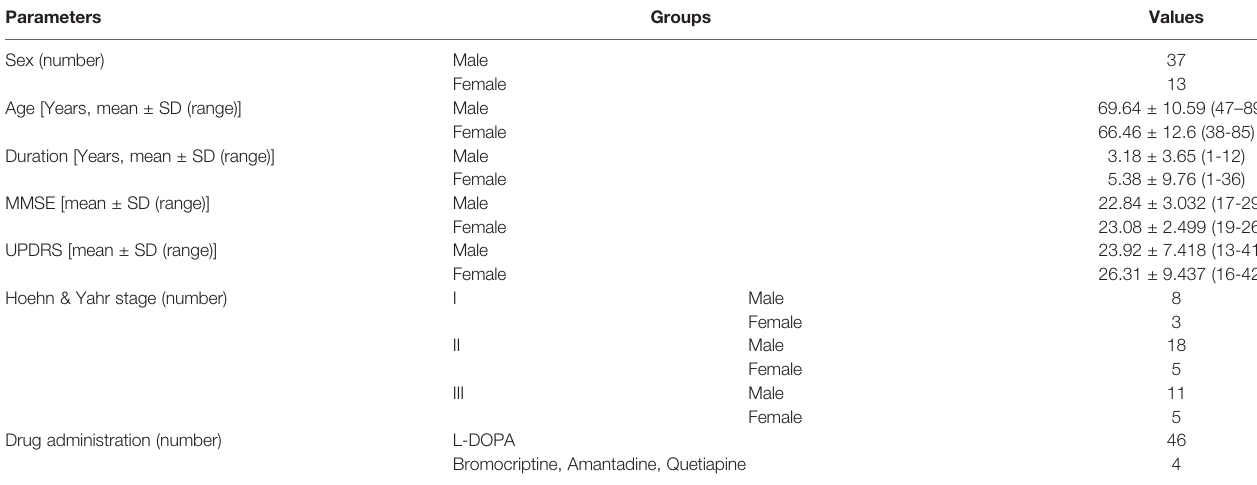
TABLE 2 | Demographic and clinical pro fi les of PD patients and healthy controls [The Mini-Mental State Examination (MMSE), Uni fi ed Parkinson ’ s Disease Rating Scale (UPDRS)].